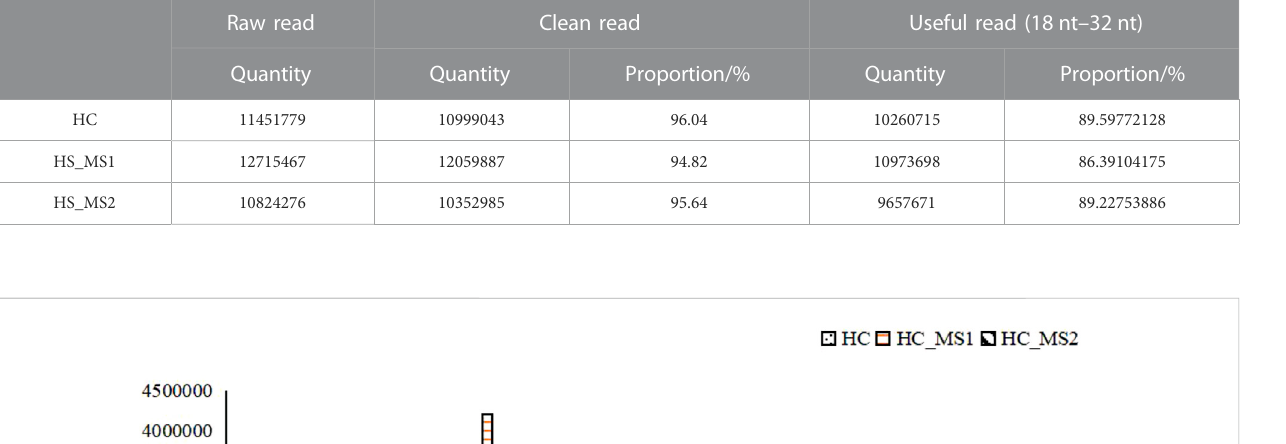
TABLE 2 Sequencing data of microRNA libraries (n = 6).